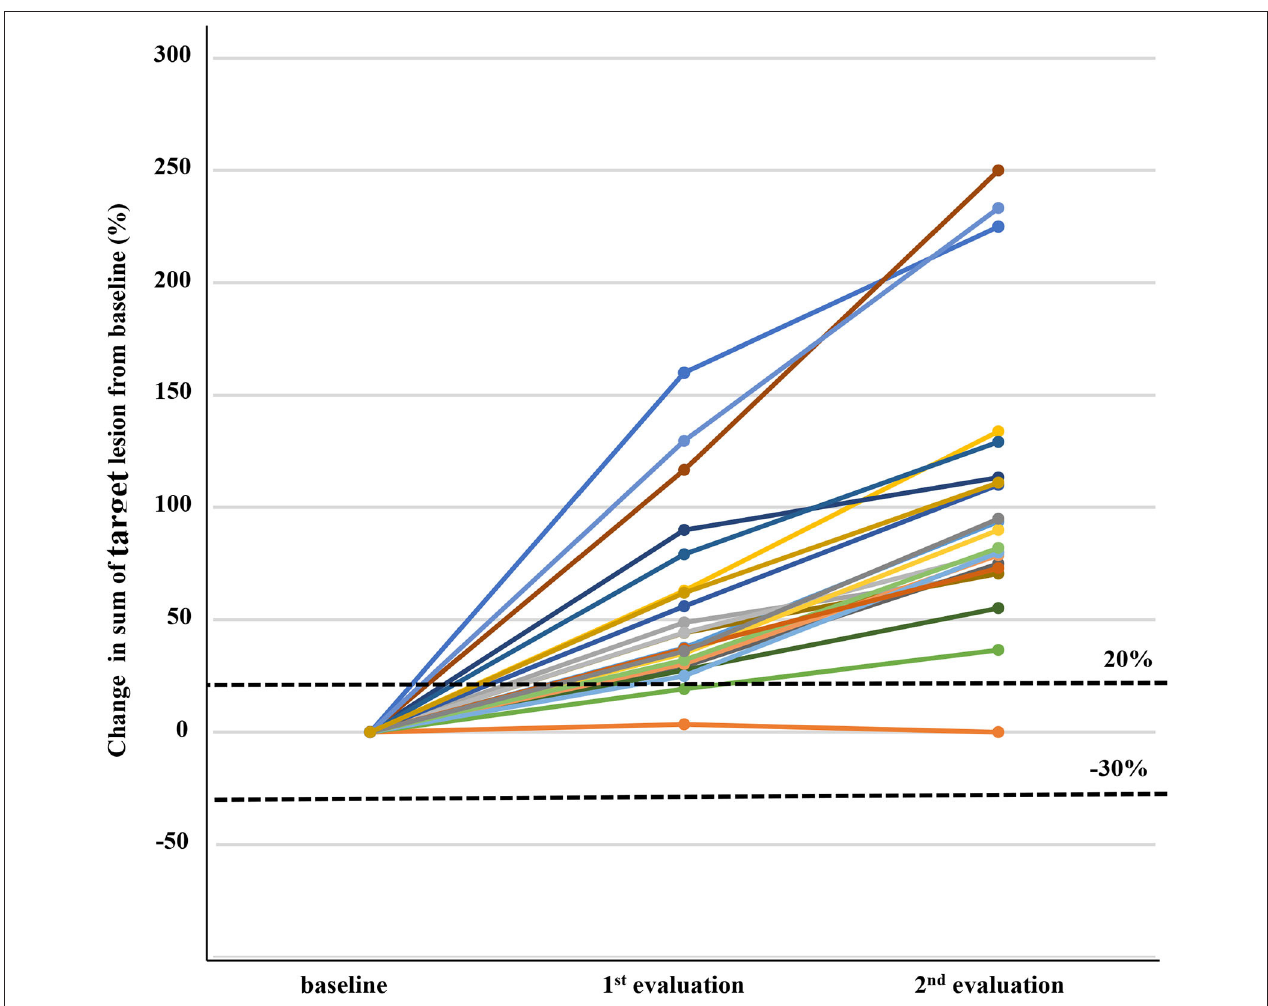
FIGURE 2 | Changes in target lesions from baseline in 22 patients with immune unconfirmed progressive disease who continued immune checkpoint inhibitor treatment and subsequent response evaluation. Three patients in the first response evaluation and seven patients in the second response evaluation did not show more than 20% increase of sum of target lesions, but were assigned as progressive disease because of new lesion